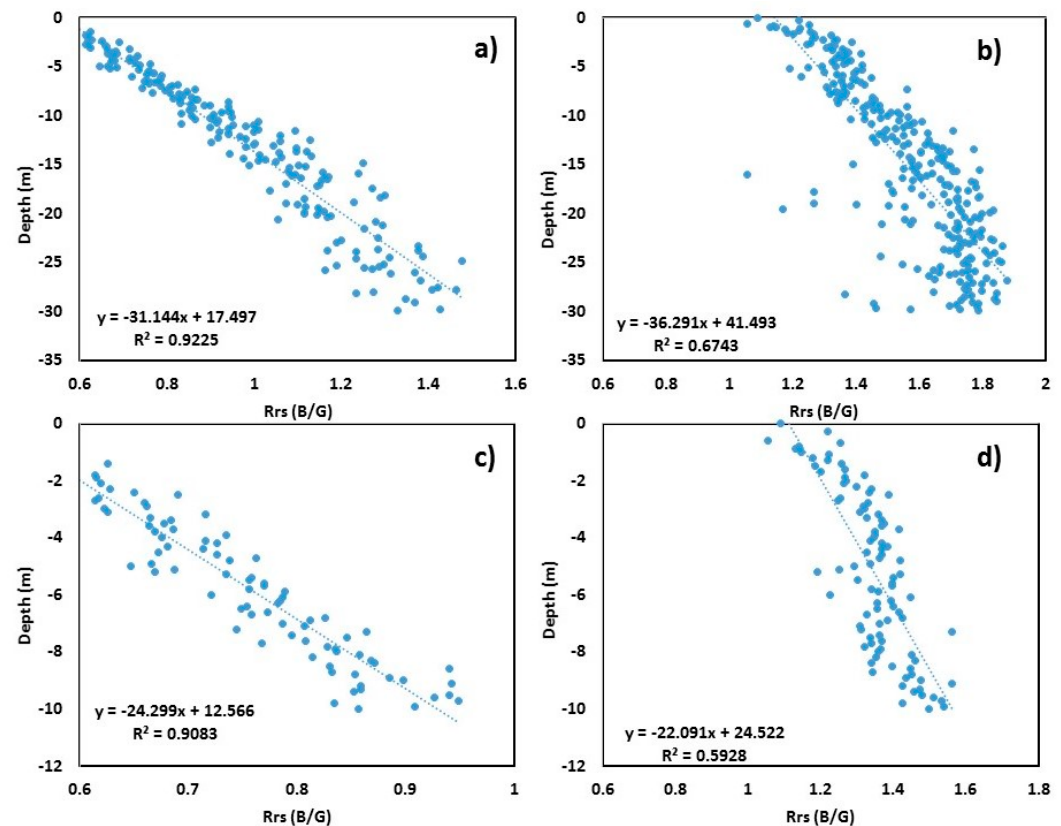
Figure 5. Scatter plots of blue/green (B/G) band versus surveyed depth for Lake Huron: ( a ) Sentinel-2 B/G vs. surveyed bathymetry up to 30 m depth; ( b ) Landsat-8 B/G vs. surveyed bathymetry up to 30 m depth; ( c ) Sentinel-2 B/G vs. surveyed bathymetry up to 10 m depth; ( d ) Landsat-8 B/G vs. surveyed bathymetry up to 10 m depth.